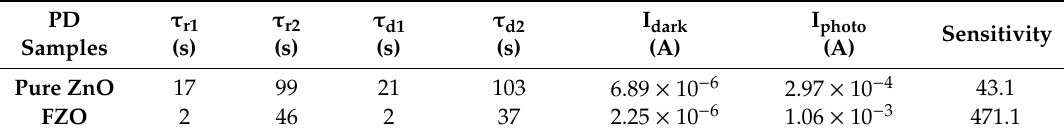
Figure 6. ( a , b ) I – T responses of photocurrent from pure ZnO and FZO NR PDs to UV light at 3 V applied bias. ( c , d ) I – V characteristics of fabricated ZnO MSM PDs with and without Fe content measured in the dark and 380 nm UV light environment. Table 1. The results exhibited the parameters of the prepared PD samples with and without Fe content at 3